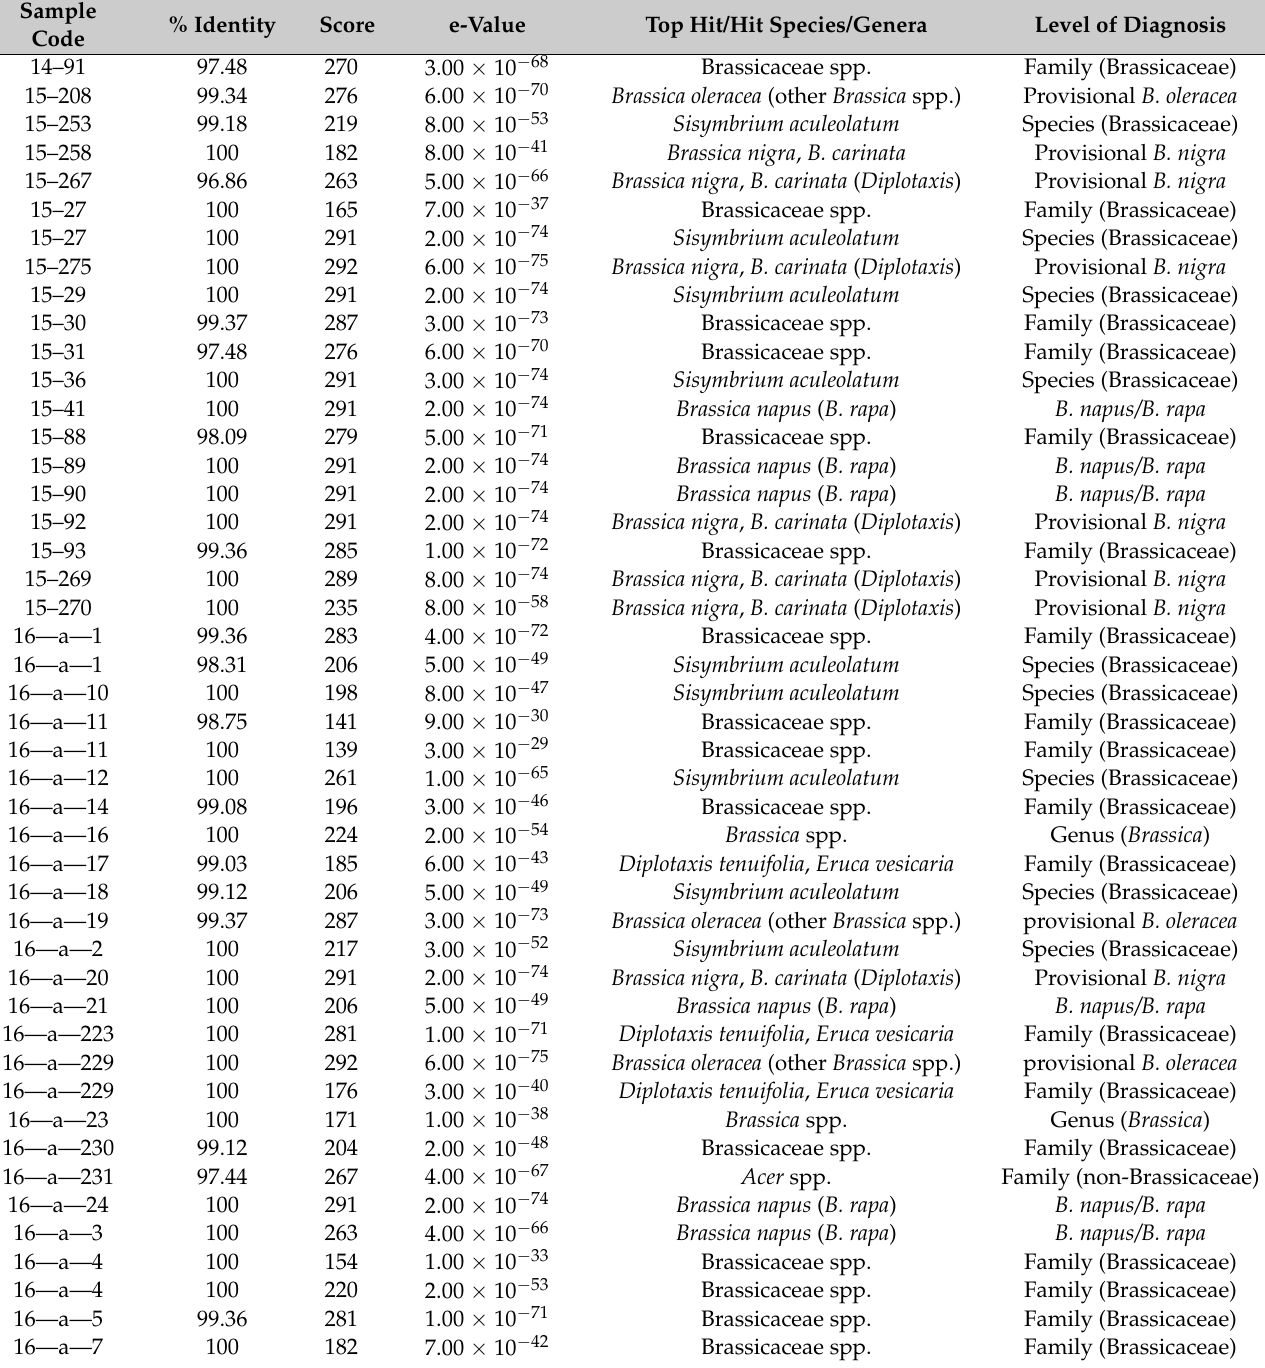
Table 3. Taxonomic diagnosis using matK5 . Best match results recovered on BOLD Systems v4 and NCBI databases using amplicon sequences of matK5 recovered from the study sites (only the highest match is shown). The percentage sequence identity and similarity score are shown, along with whether probability of a match was lower than 10 − 5 . The species sharing the highest number of hits are provided, along with the lowest level of taxonomic diagnosis possible based on aDNA (given that all seeds possessed Brassicaceae-type seed